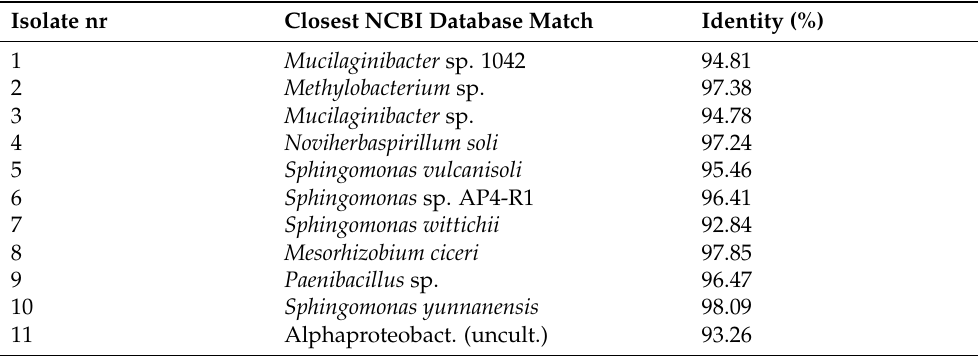
Table 1. Identification of endophytic bacteria isolated from N. caerulescens seeds using sequencing results of the 16S rDNA gene Sanger sequencing. The identity percentage is the extent to which the given sequence aligns with the sequence found in the NCBI